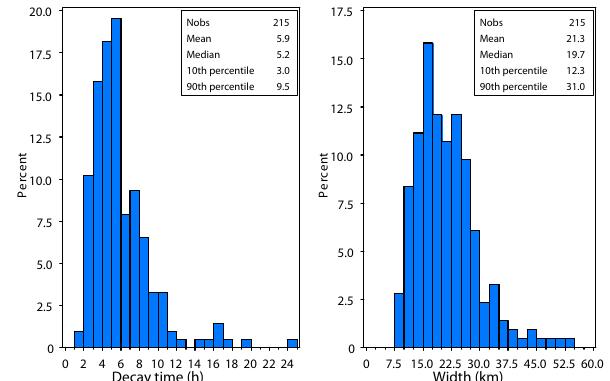
Figure 2. The distribution of the estimated decay time ( τ) and plume width ( σ) obtained from the fit of OMI data for the 2005– 2007 period. Data from 215 catalogue sites that produced estimates of σ and τ with small uncertainties were used for the plot. The main statistical characteristics of the distribution are also shown (the number of observations is labelled as